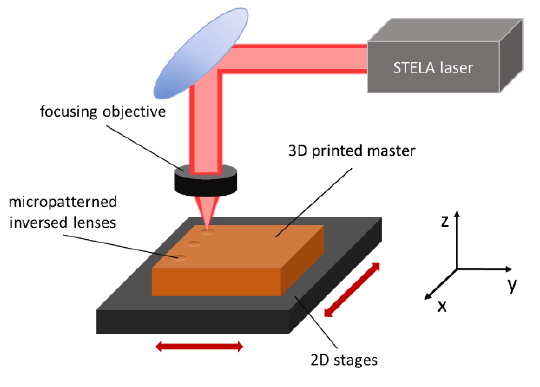
Fig. 2. PLA micropatterning principle.